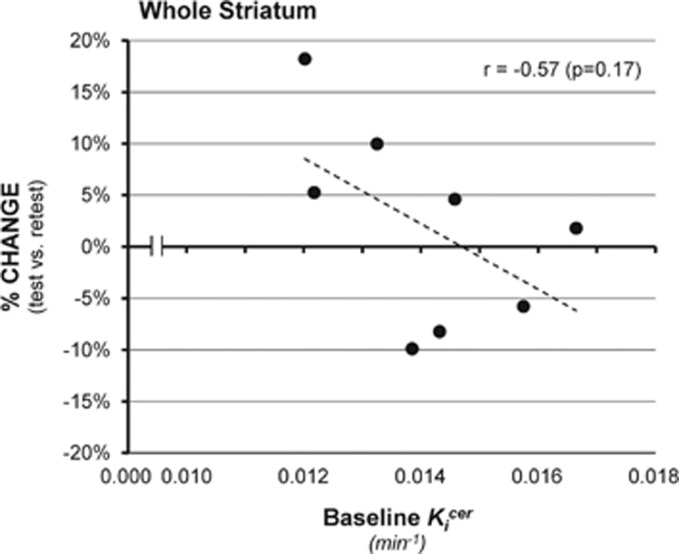
Kicer at baseline and follow-up, indicating no significant difference in dopamine synthesis capacity under rest conditions.